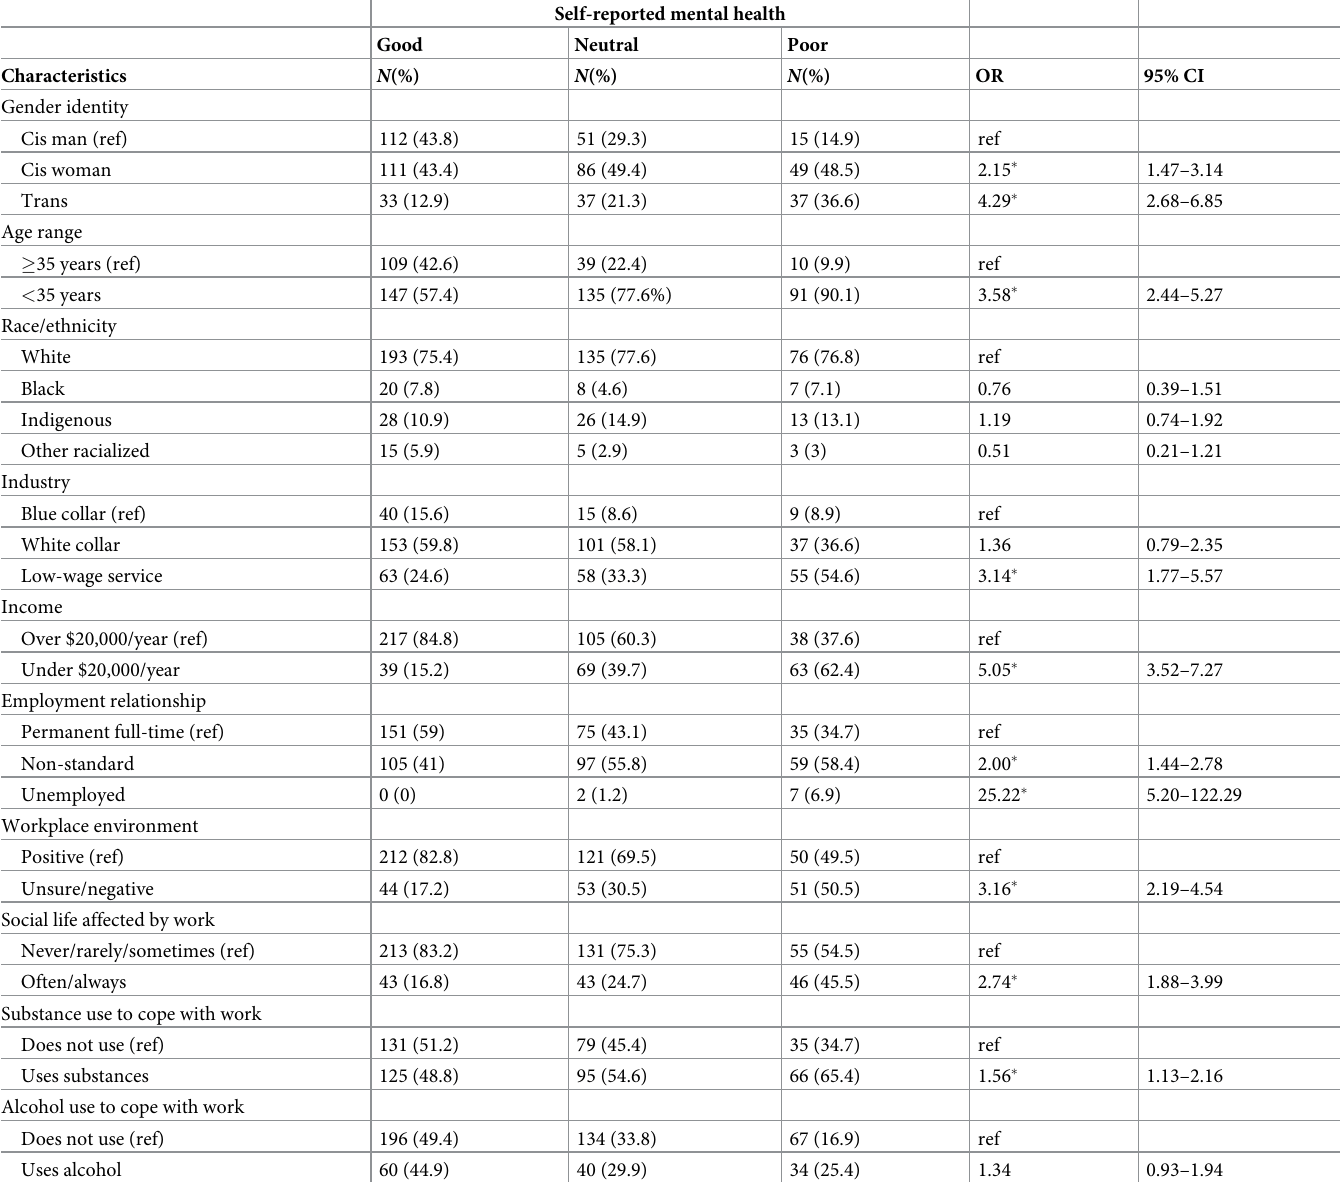
Table 1. Sociodemographic, economic, and employment characteristics of LGBTQ workers by reported mental health: Good (ref., n = 256), neutral (n = 174), and poor (n = 101), and univariate ordered logistic regression models for each variable (‘neutral’ and ‘poor’ mental health compared to ‘good’ referent category).